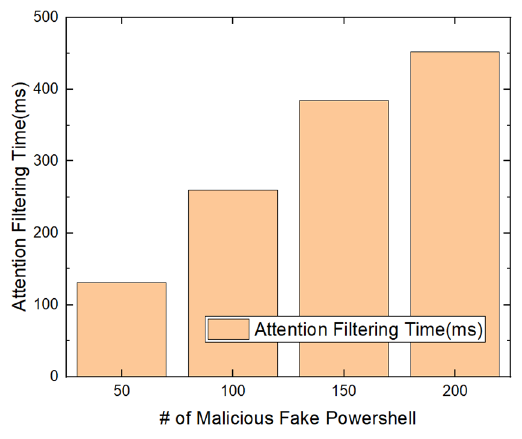
Figure 10. Attention Filtering Time.